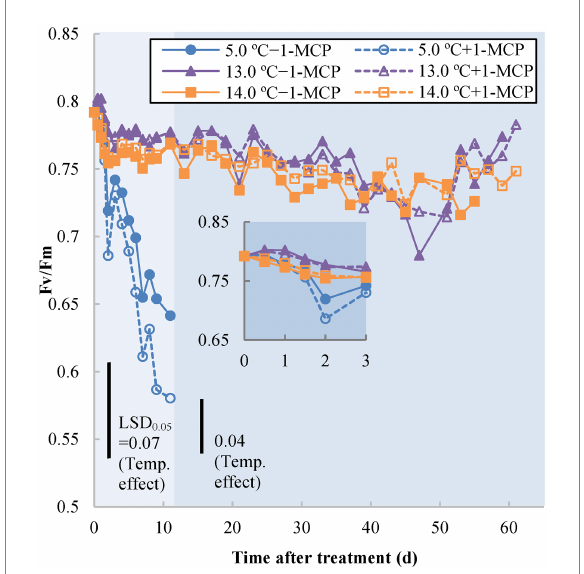
FIGURE 2 Photochemical efficiency as measured by dark-adapted status photosystem II chlorophyll fluorescence (Fv/Fm) of banana peel initially treated with 0 ( − 1-MCP) or 50 μ L L − 1 (+ 1-MCP) aqueous 1-MCP for 60 s at 23.0 ° C and transferred to 5.0, 13.0 or 14.0 ° C storage with 95% RH ( n = 6). LSD 0.05 values varied within different time frames shown by different background shading (days 0–11; days 13–61) due to the various shelf-life durations of